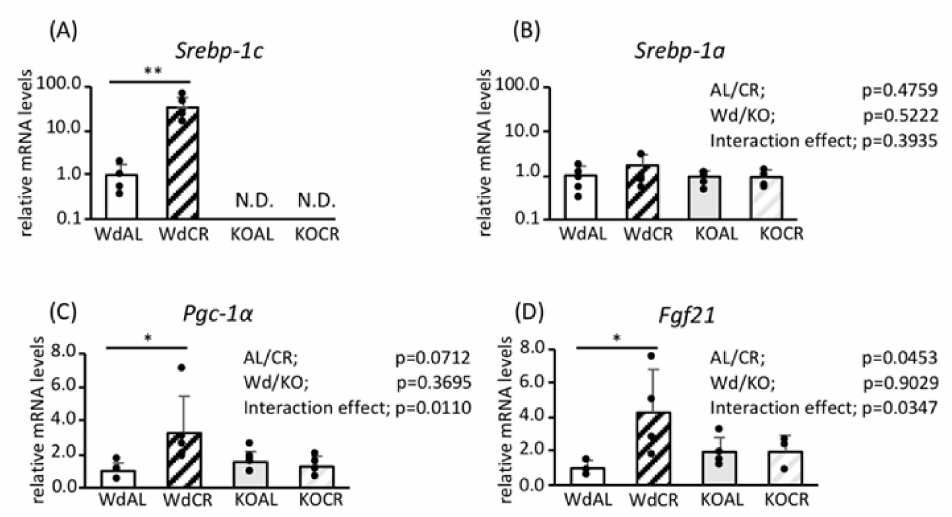
Figure 1. The e ff ects of Srebp-1c KO on the expression of key regulators of CR-associated metabolic remodeling in the WAT of mice on a C57Bl / 6 background. The mRNA expression levels of Srebp-1c ( A ), Srebp-1a ( B) , Fgf21 ( C ), and Pgc-1a ( D ) in WAT were measured using RT-PCR and were normalized to Tbp expression ( n = 4). Values are means ± SDs. * p < 0.05, ** p < 0.01 vs. AL, according to Student’s t -test, or two-way ANOVA and Tukey’s